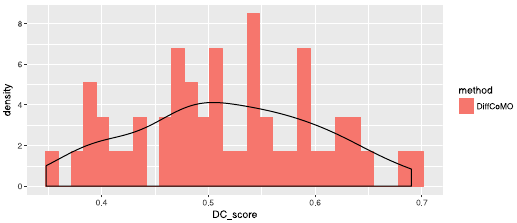
Figure 14. Distribution of DC _ Score of all differentally coexpressed modules identified by DiffCoMO in dataset